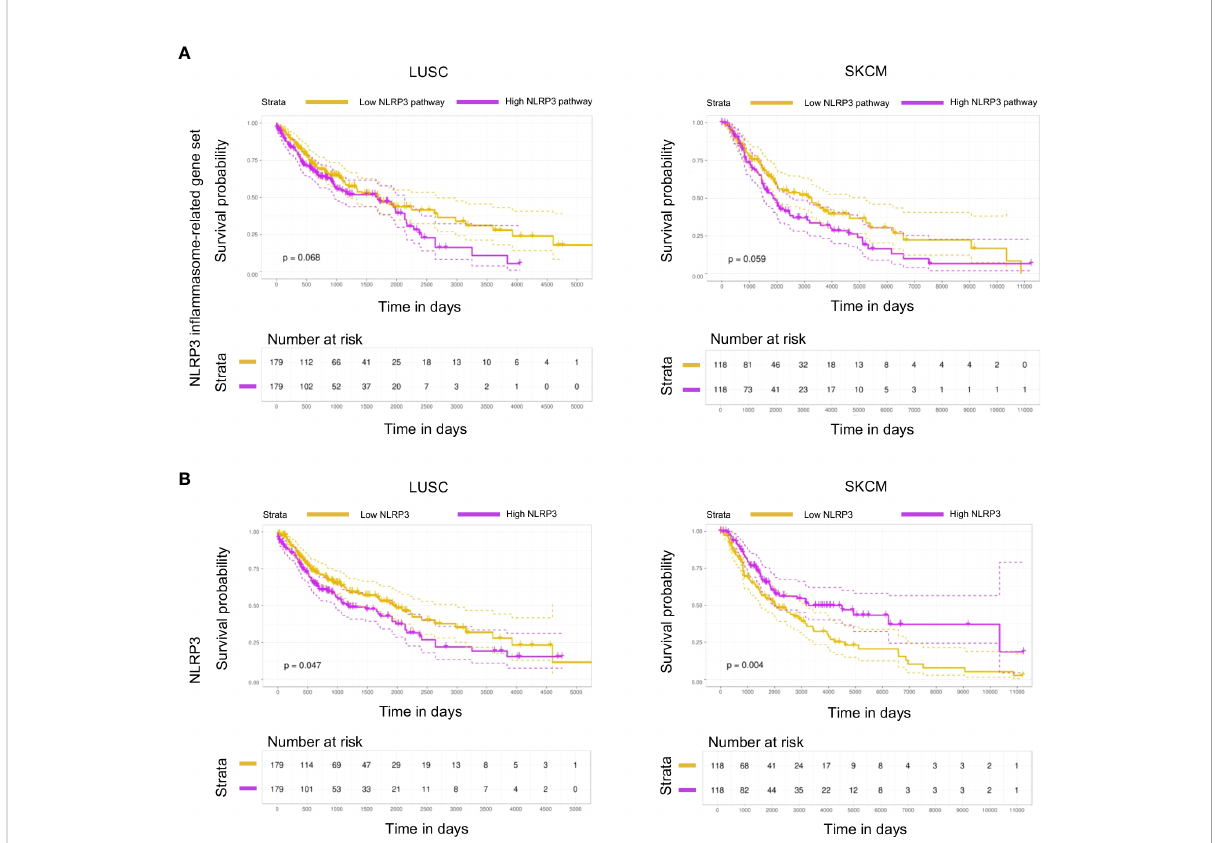
FIGURE 1 NLRP3 expression is associated with survival in melanoma and lung cancer patients. (A,B) Kaplan – Meier plot with patients-at-risk table showing overall survival of TCGA datasets LUSC (lung squamous cell carcinoma; left) and SKCM (skin cutaneous melanoma; right), with patients strati fi ed by NLRP3 in fl ammasome-related gene set (A) and NLRP3 (B) expression using top and bottom 33% of strati fi ed patients. Gene-set strati fi cation is based on the median expression of all 30 containing genes. Dotted lines represent 95% con fi dence intervals. Statistical evaluation was performed using the log-rank